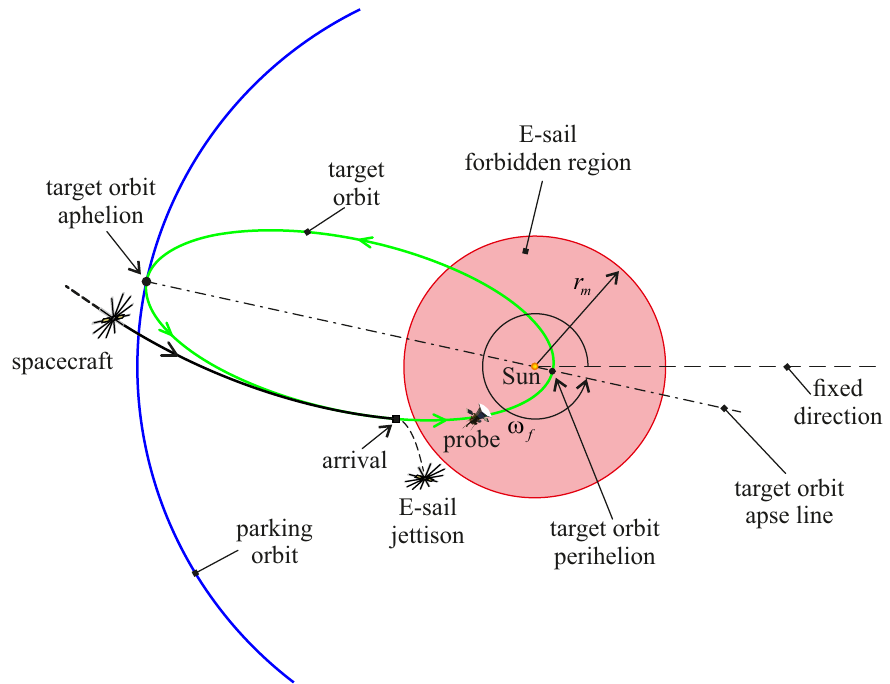
Figure 2. Target orbit Ecliptic position.